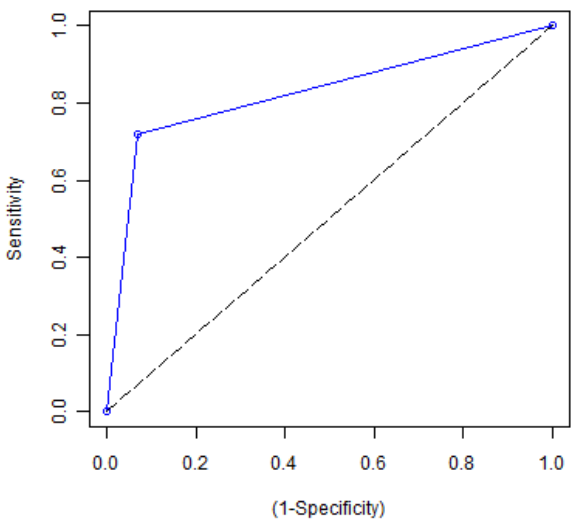
Figure 6. ROC curve for high-resolution built-up mask, which has been extracted from Quickbird.